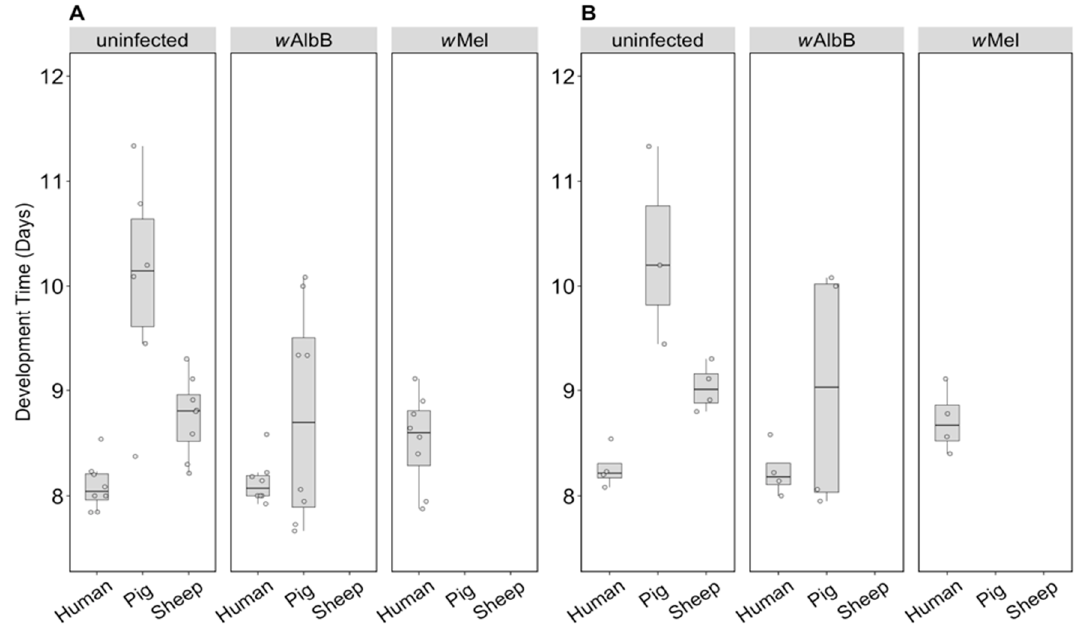
Figure 5. Comparison of development time across infection types (uninfected, w Mel, w AlbB) and different blood sources (human, pig, sheep). The development time in days, calculated as the number of days from being hatched (day 0) to emerging as adults was measured for ( A ) males and ( B ) females. Individual data points indicate the average development time of mosquitoes in each replicate based on 4–22 individuals. The boxplots represent the first to the third quartiles around the median (horizontal grey line) and the vertical bars represent the 1.5 interquartile of the lower and upper quartiles.